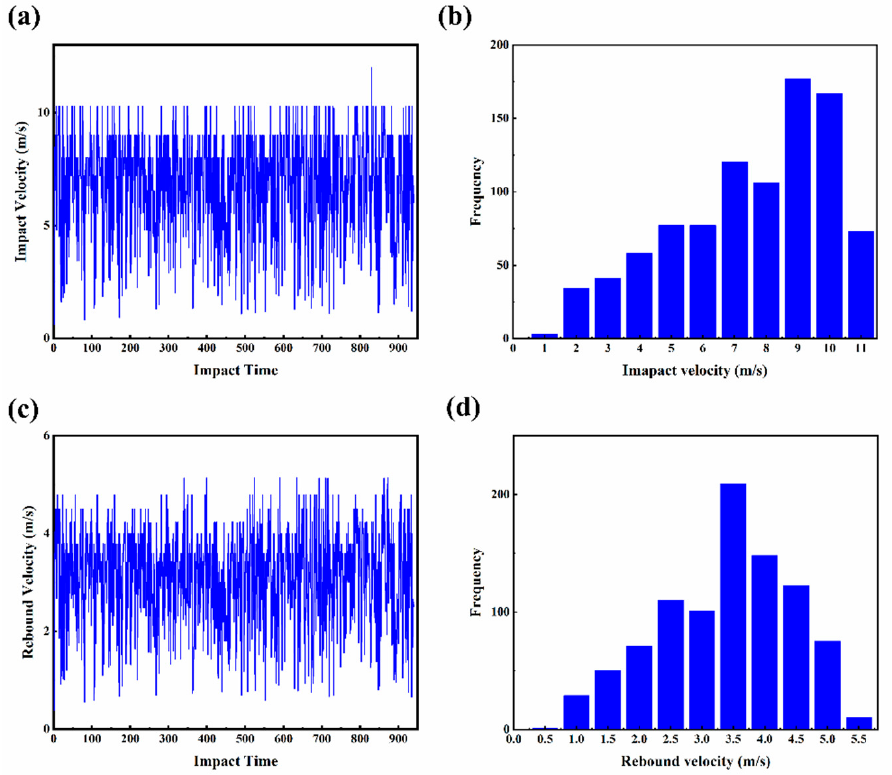
Figure 7. Data analysis of the motion behavior of a shot during ultrasonic shot peening process captured via the fast speed camera for 1 s: ( a ) the impact velocity of the shot; ( b ) the frequency of the impact velocity; ( c ) the rebound velocity of the shot; and ( d ) the frequency of the rebound velocity.